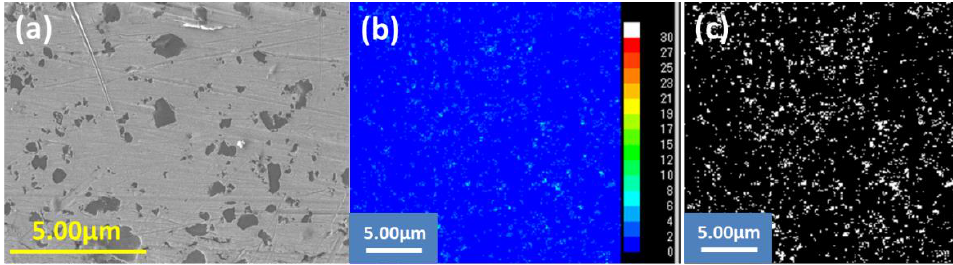
Figure 3. EPMA/EDS mapping of the silicon element within the ROI region ( a , b ) and the corresponding volumetric fraction of Si 3 N 4 within the Ni – Co – P matrix after Image J processing ( c ).